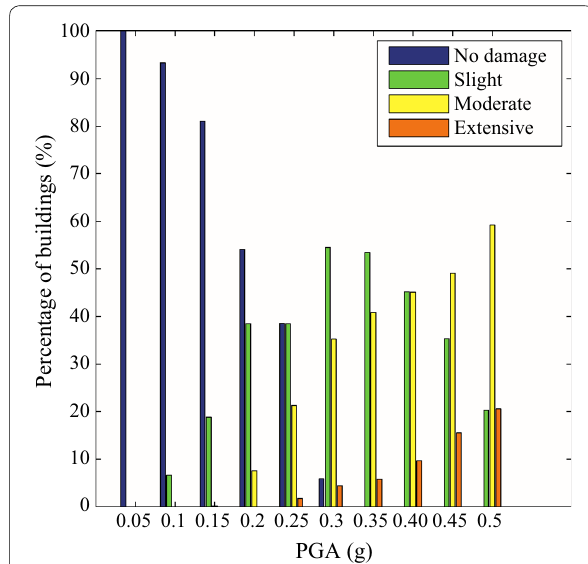
Fig. 11 Histograms depicting the predicted distribution of damage grades, from no damage ( blue ) to extensive ( orange ), among the whole set of buildings surveyed in Beirut, as a function of the rock PGA loading level (0.05–0.5